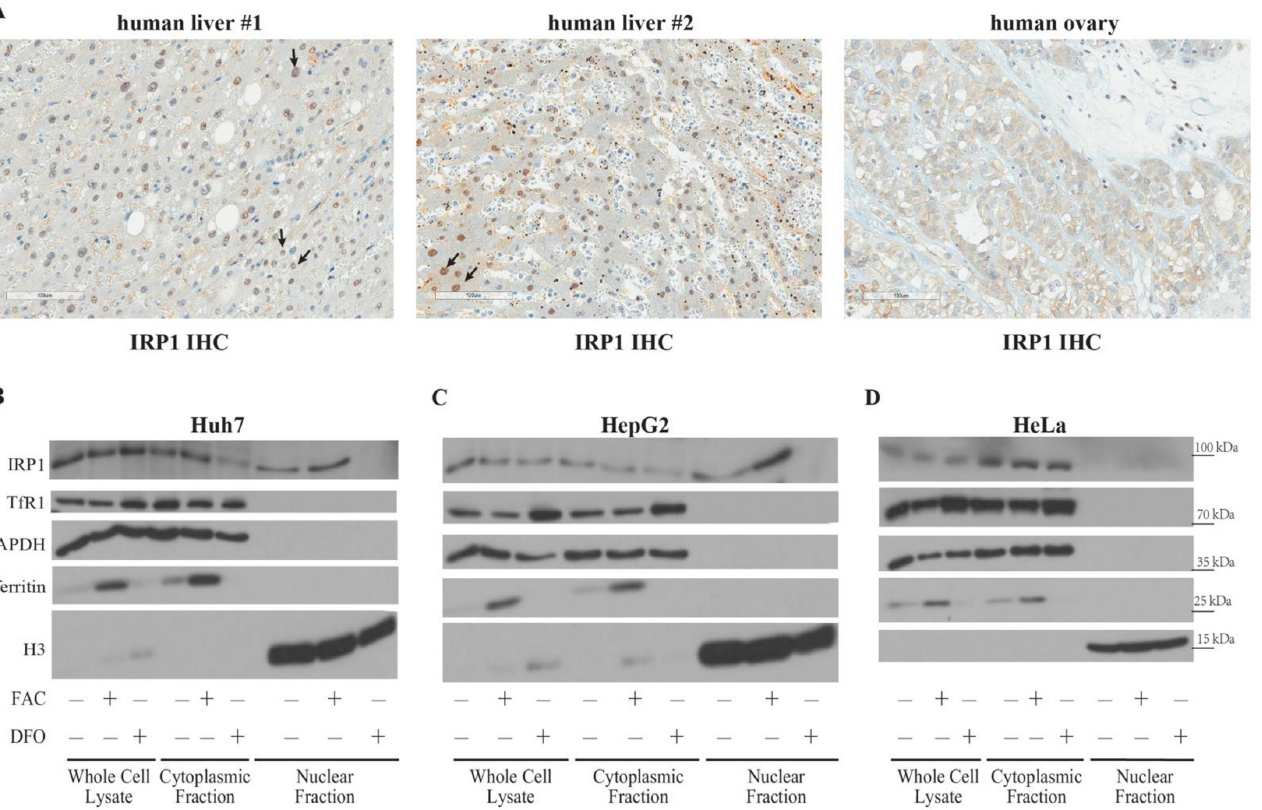
Figure 3. Nuclear expression of IRP1 in human liver sections and hepatoma cell lines. ( A ) Subcellular IRP1 localization in human liver and ovary biopsies. IRP1 expression was analyzed by immunohisto- chemistry (IHC). Arrows indicate apparent nuclear staining in the liver samples. ( B – D ) Western blot analysis of IRP1, TfR1, GAPDH, ferritin and H3 in whole cell lysates, cytoplasmic supernatants and nuclear extracts from Huh7 ( B ), HepG2 ( C ) and HeLa ( D ) cells previously left untreated or treated for 18 h with 100 µ g/mL FAC or 100 µ M